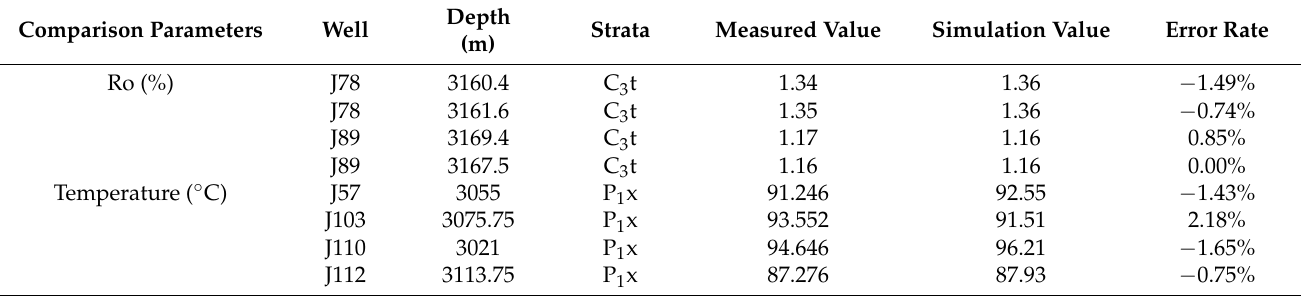
Table 4. Comparison of Ro and temperature between measured values and simulation results of PetroMod